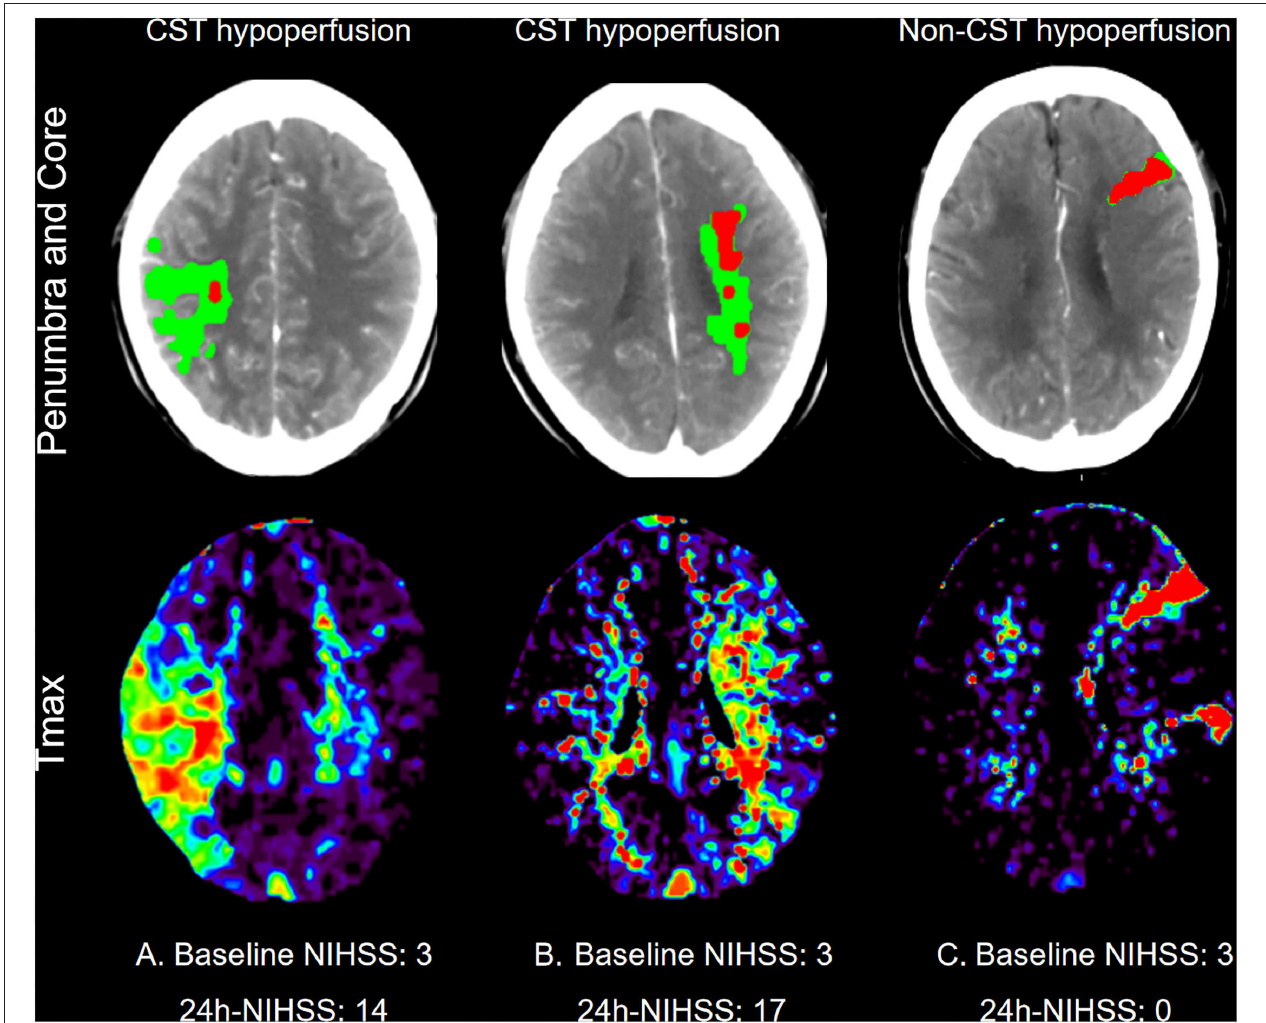
FIGURE 1 | Representative examples of patients who underwent computed tomography perfusion at baseline. First line: Penumbra (Green Area) and core (Red Areas) Map; Second line: Time to maximum of tissue residue function (Tmax) map. (A) One patient with CST hypoperfusion at right corona radiata, baseline NIHSS: 3; 24h-NIHSS: 14. (B) One patient with CST hypoperfusion at left lateral ventricle, baseline NIHSS: 3; 24h-NIHSS:17. (C) One patient with non-CST hypoperfusion, baseline NIHSS: 3; 24h-NIHSS: